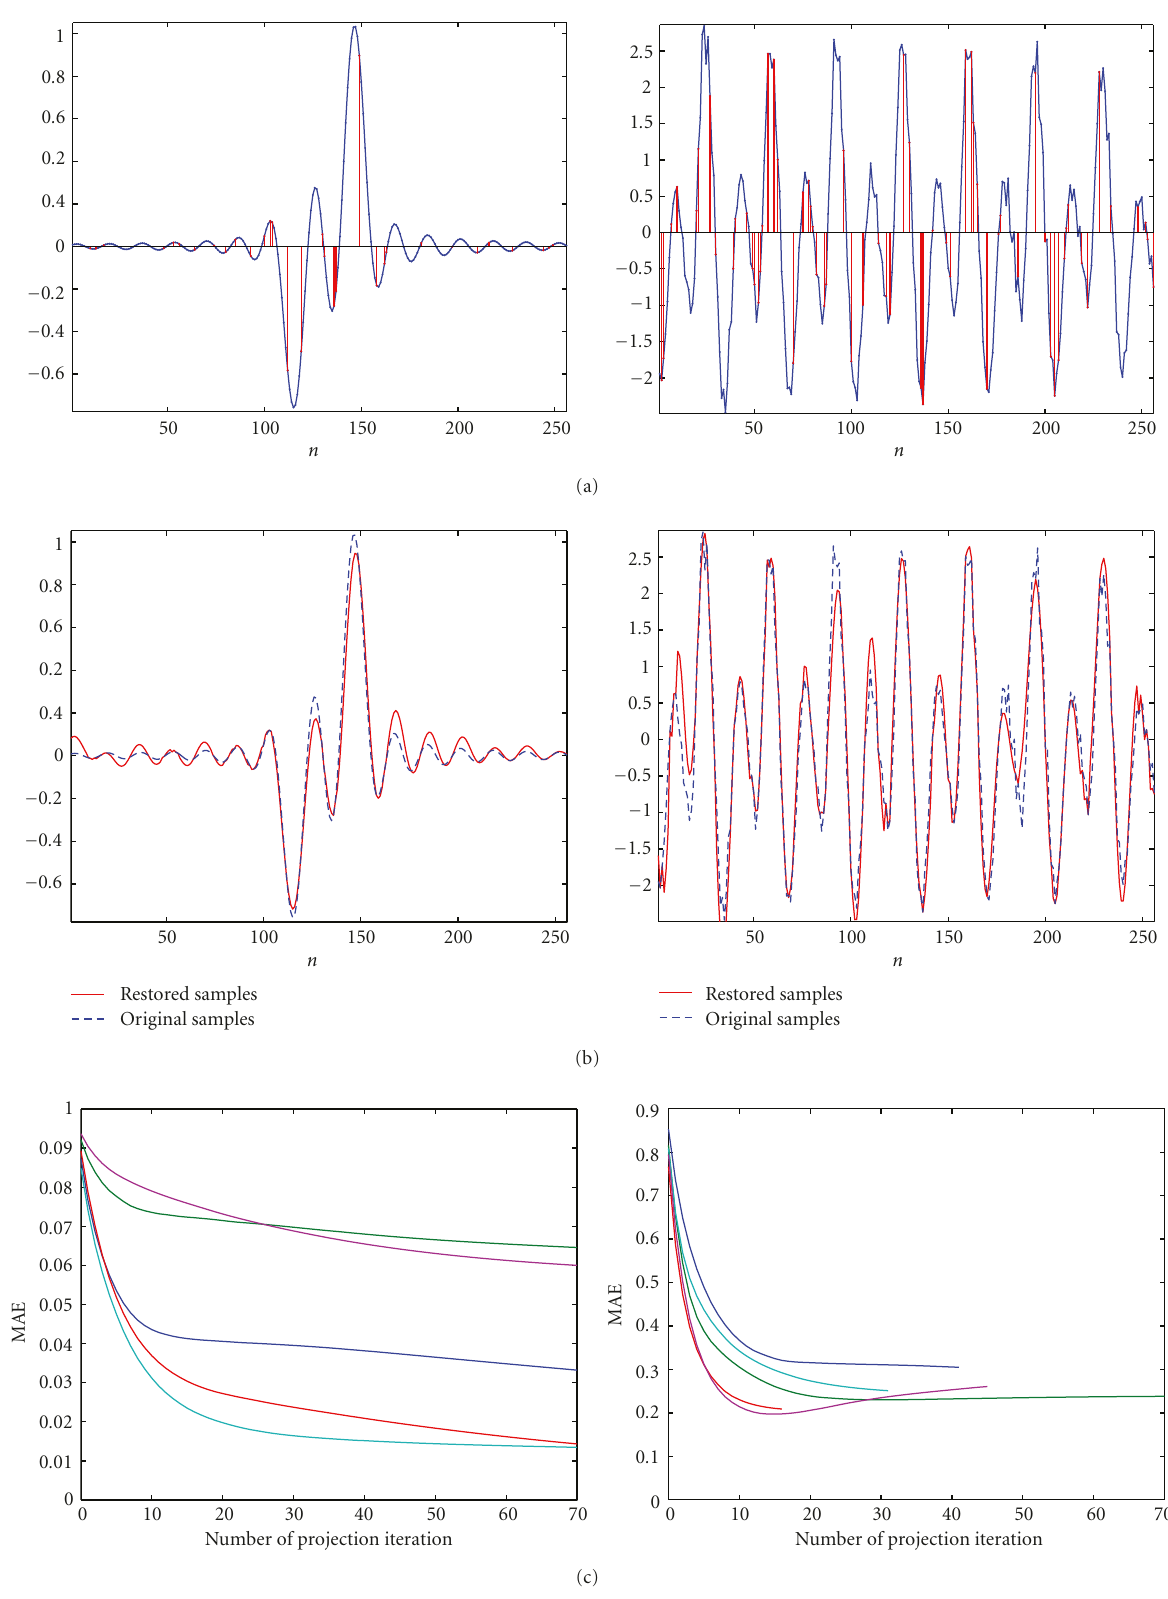
Figure 8: Restored results for randomly-spaced subsamples. (a) Randomly spaced subsampled test and speech signals, (b) restored test signal by baseband DPSS-based DET ( L = 8, K = 32) and restored speech signal by bandpass DPSS-based DET ( L = 4, K = 16), and (c) convergence behaviours of 5 di ff erent random sampling patterns (left: test signal, right: speech